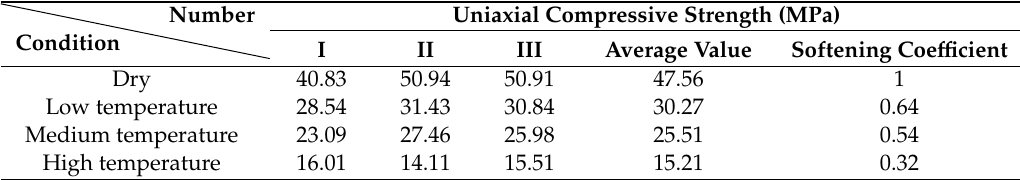
Table 3. Rock sample compressive strength